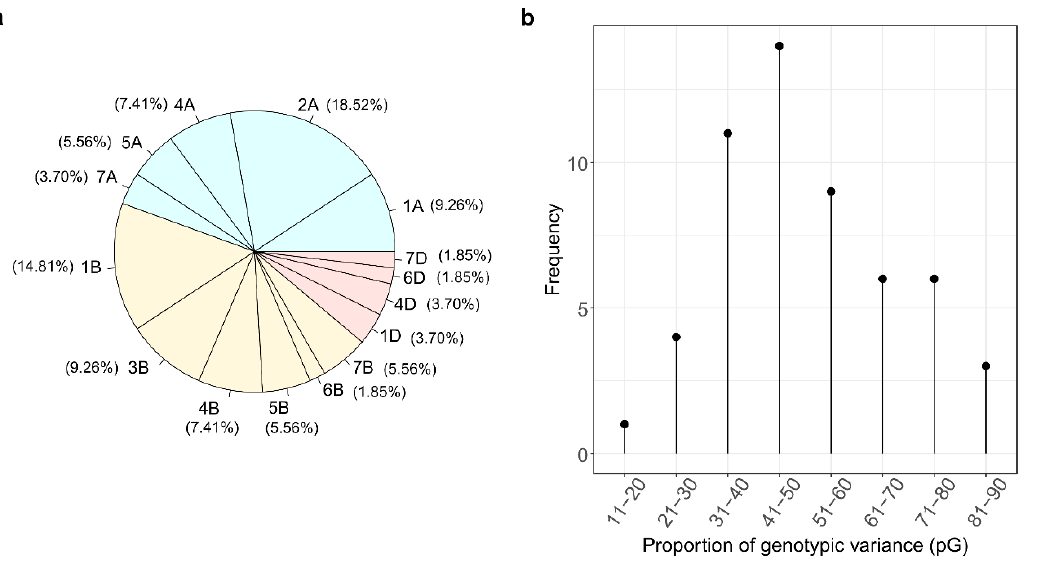
Figure 2. ( a ) Pie chart showing the distribution of the 54 major QTLs on different chromosomes; ( b ) frequency of the proportion of explained genotypic variance by the 54 QTLs.